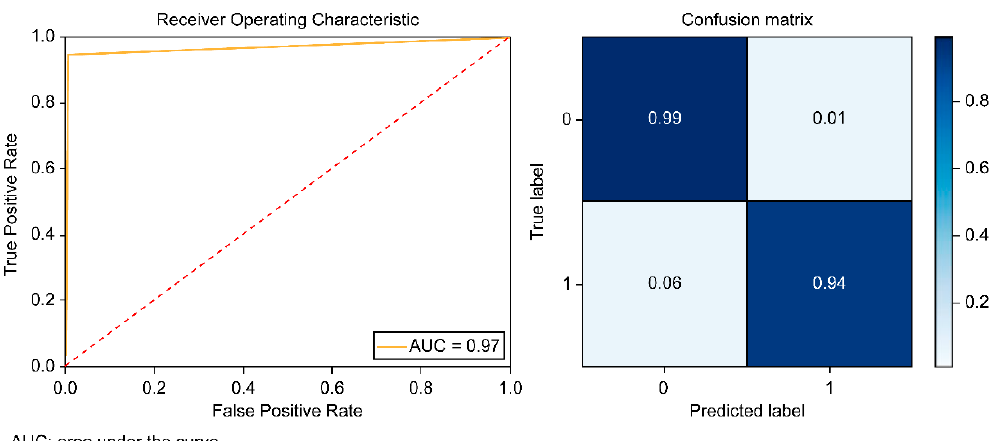
Figure 4. Diagnostic performance of the model on the test set: ROC curve ( left ) and confusion matrix ( right ). matrix ( right